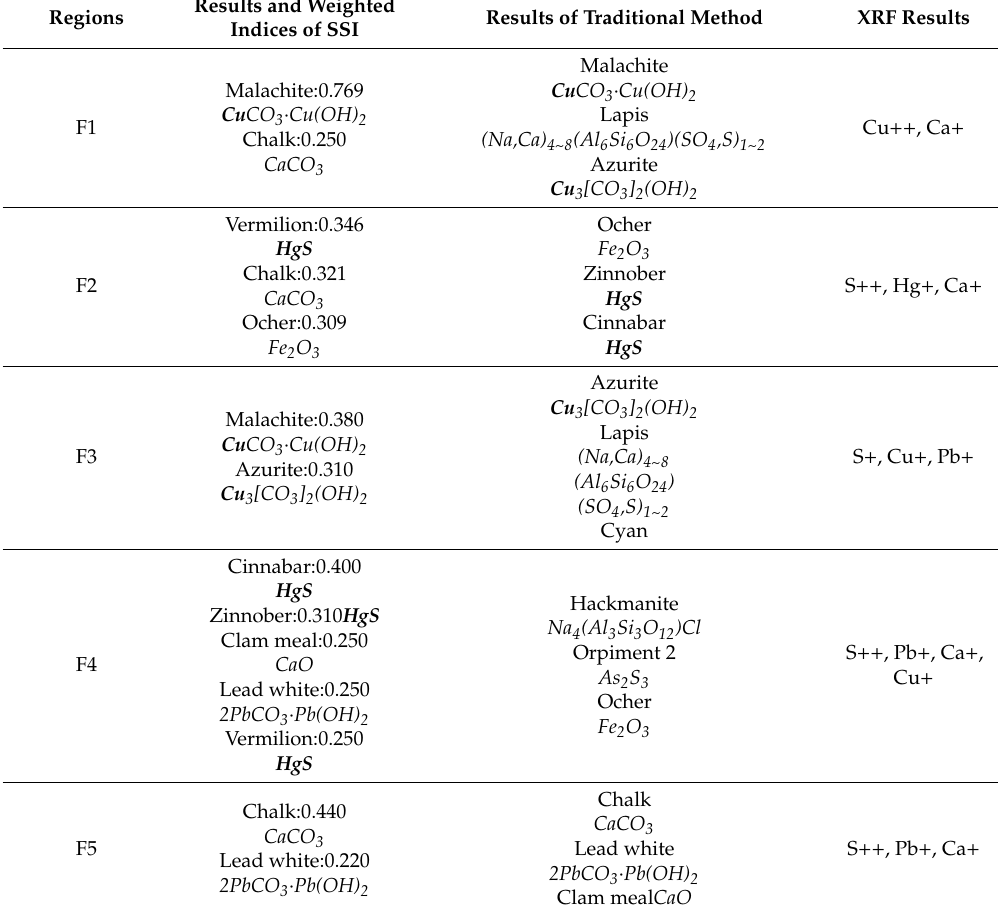
Table 12. Comparison of pigment identification in the five regions of the